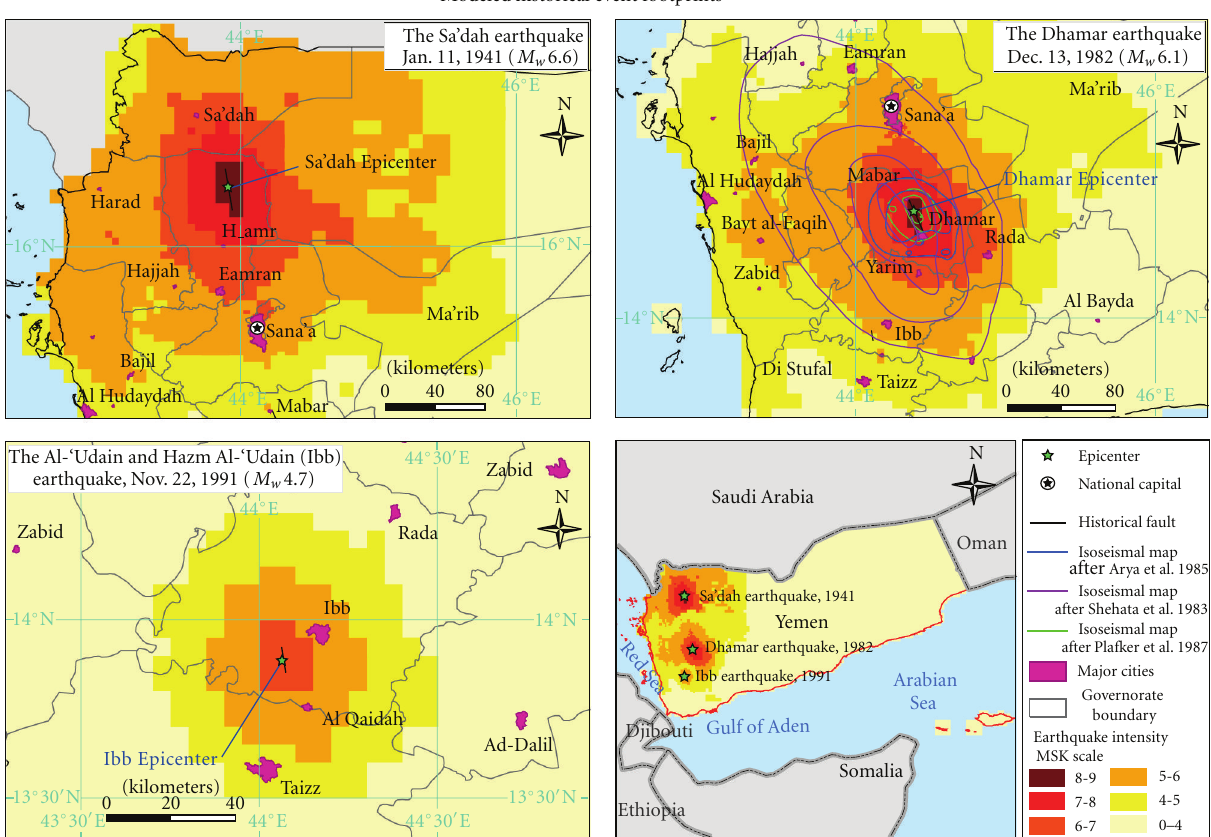
Figure 10: Modeled intensities of historical events, compared by observed intensities surveys by various authors for the Arya et al. [8], Shehata et al. 1983 [42], and Plafker etal. [6] Dhamar event.